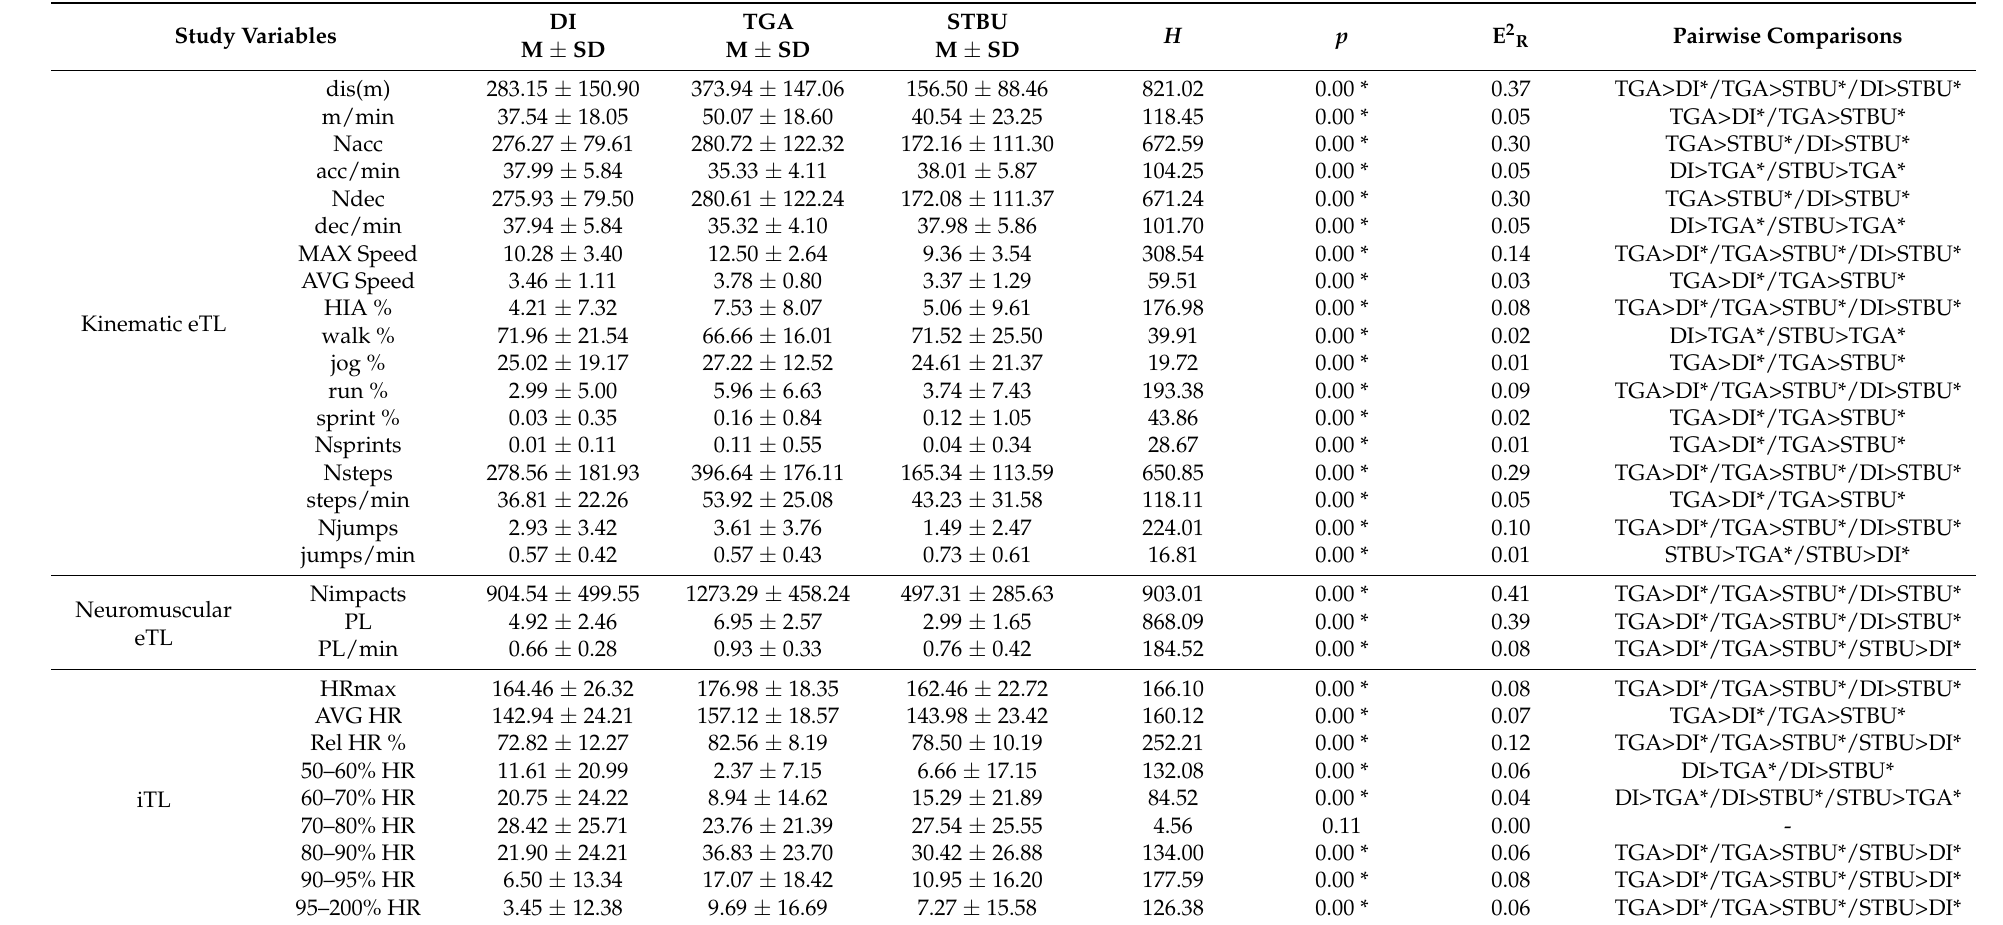
Table 1. Results of the application of the programmes according to the teaching